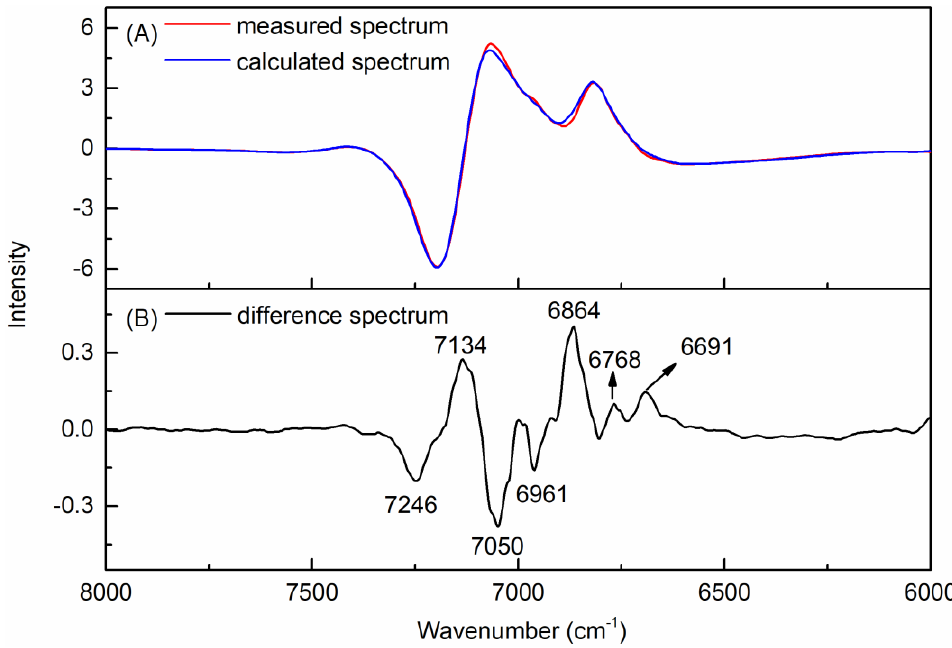
Figure 4. Transformed and calculated NIR spectrum of water ( A ) and the difference spectrum ( B ).